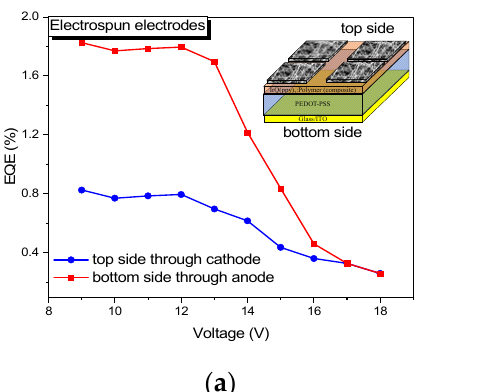
The EQE versus the applied voltage for the electrospun cathodes is almost constant